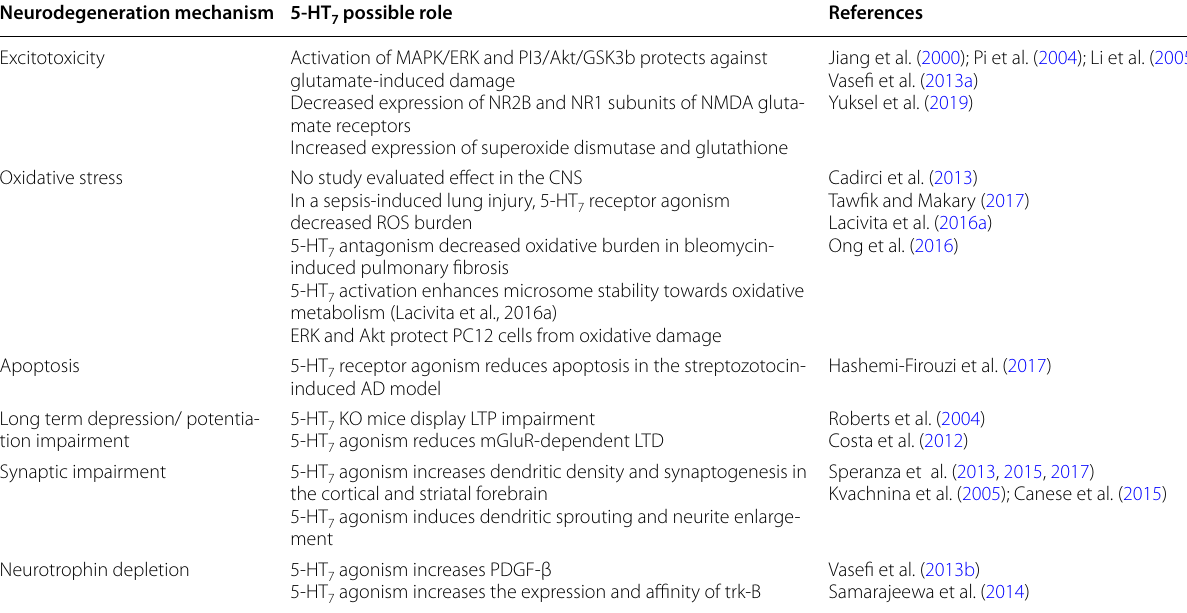
receptors agonism 7